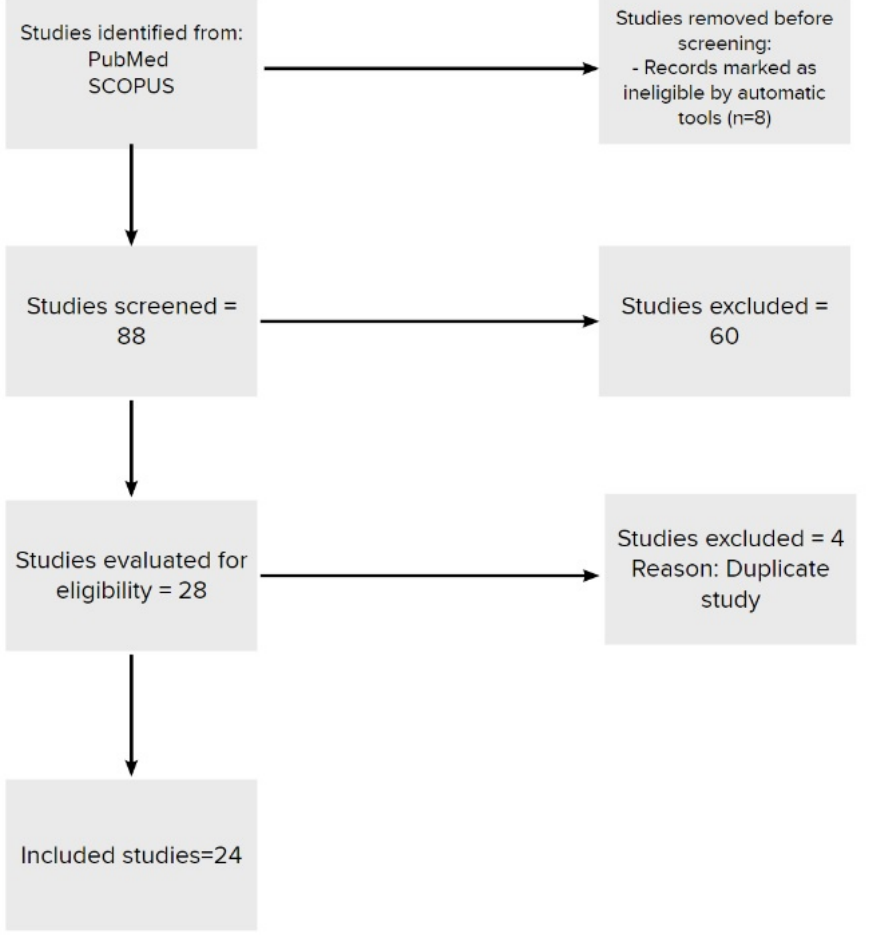
Figure 1. Flowchart of the screening and selection process.